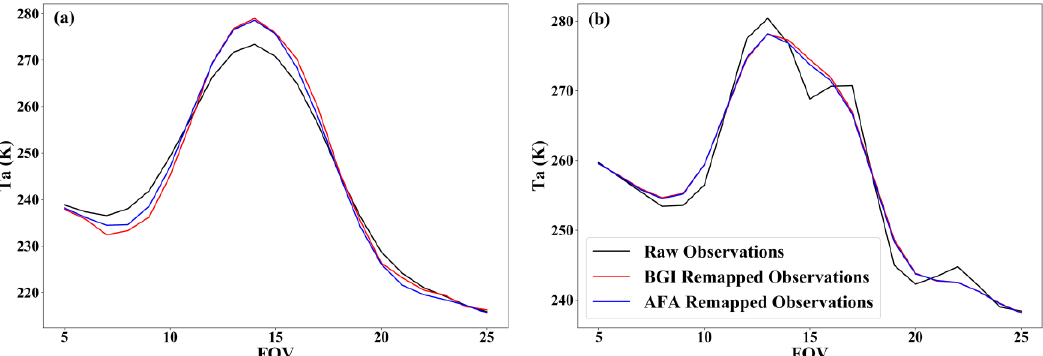
Figure 11. NOAA-20 ATMS antenna temperature cross-section through the Florida peninsula for ( a ) channel-1 resolution enhancement and ( b ) channel-3 resolution degradation. The white lines in the top panels of Figure 10 show the location of the cross-section.